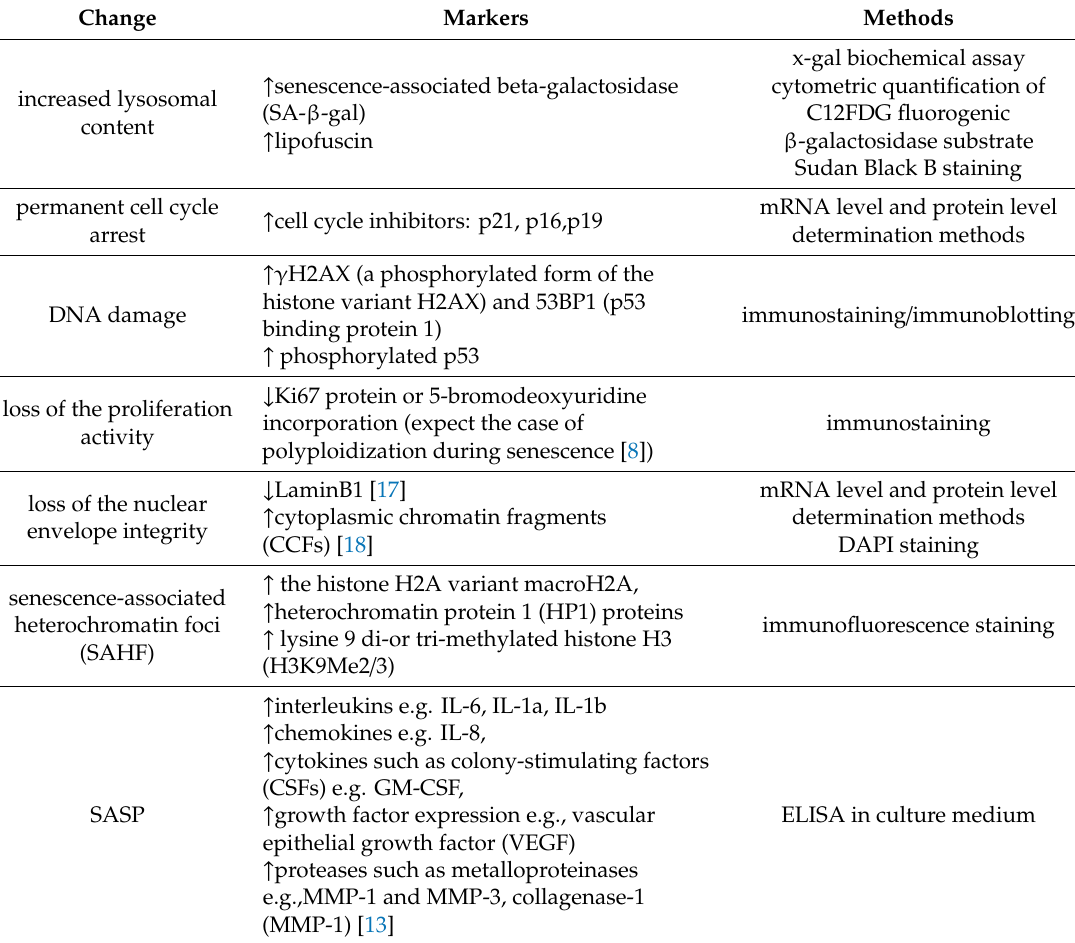
Table 2. Main changes of cell morphology, markers, and methods in senescence process